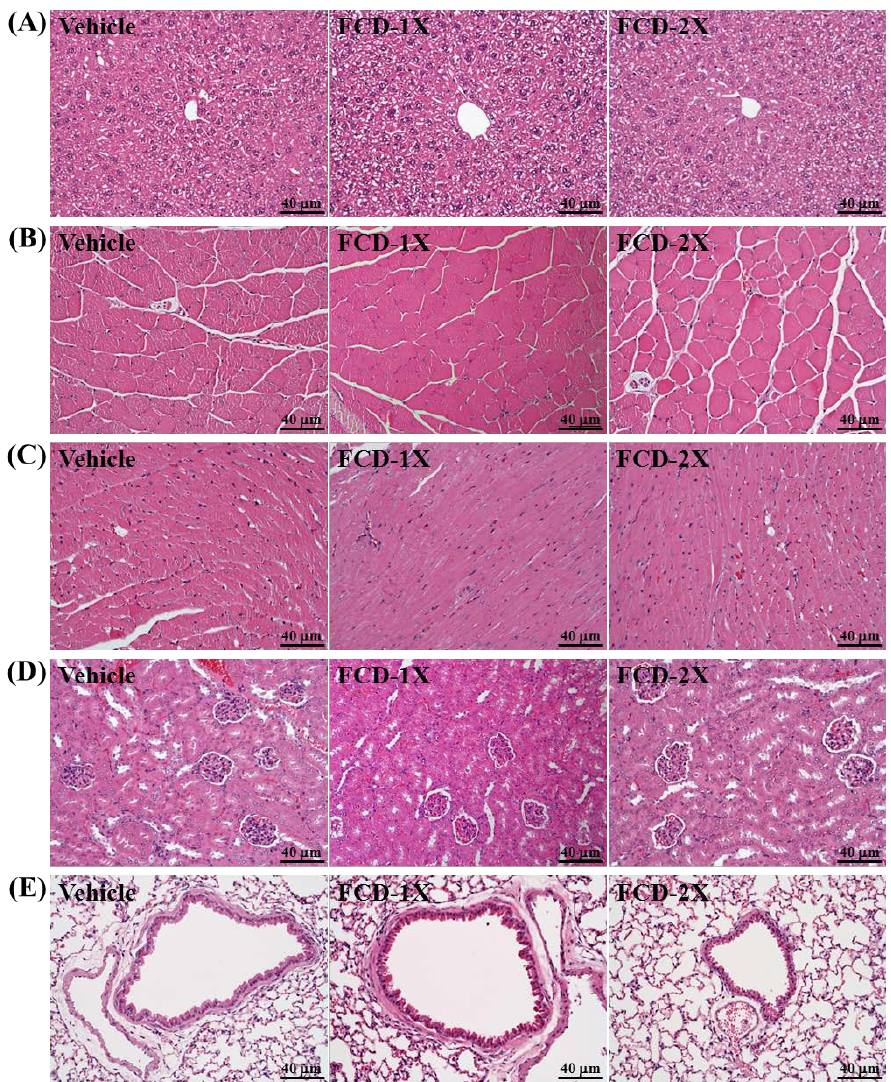
Figure 4. Effect of FCD (Fucoidan) supplementation on the morphology of liver ( A ); skeletal muscle ( B ); heart ( C ); kidney ( D ); and lungs ( E ) tissues. Specimens were photographed with a light microscope (BX-51, Olympus, Tokyo, Japan). (H & E stain, magnification: 200×, Scale bar, 40 μm). Low-dose (FCD-1X) and high-dose (FCD-2X) FCD at 310 and 620